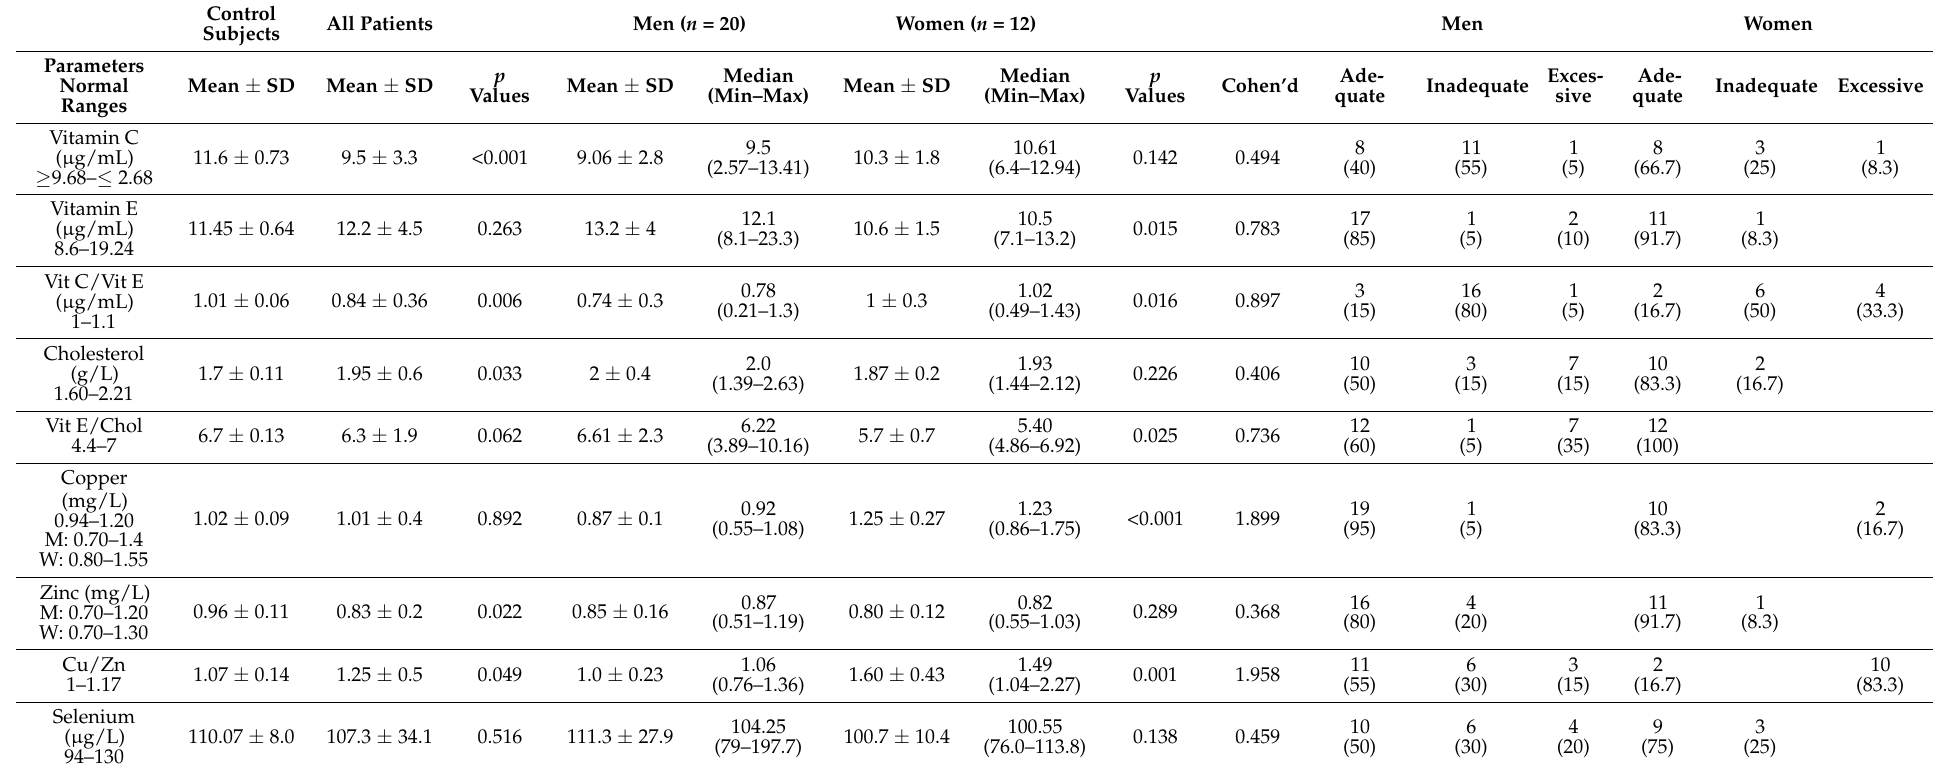
Table 11. Plasma concentrations of vitamins and oligoelements and their adequacy in controls and in 32 patients with